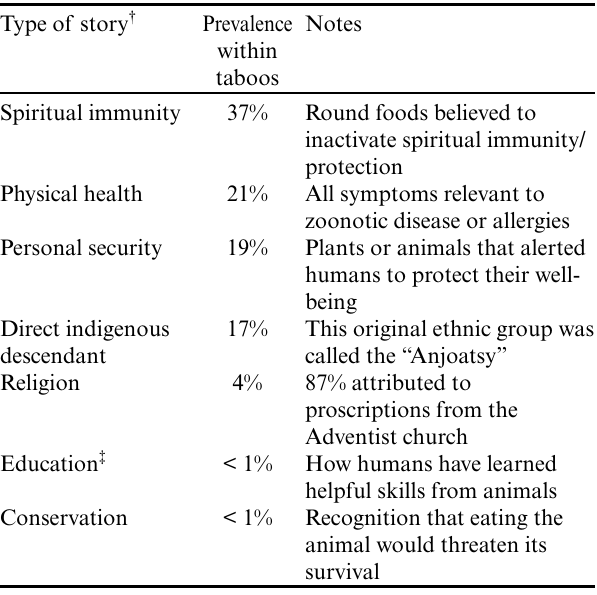
Table 1 . Categories ascribed to taboo origin